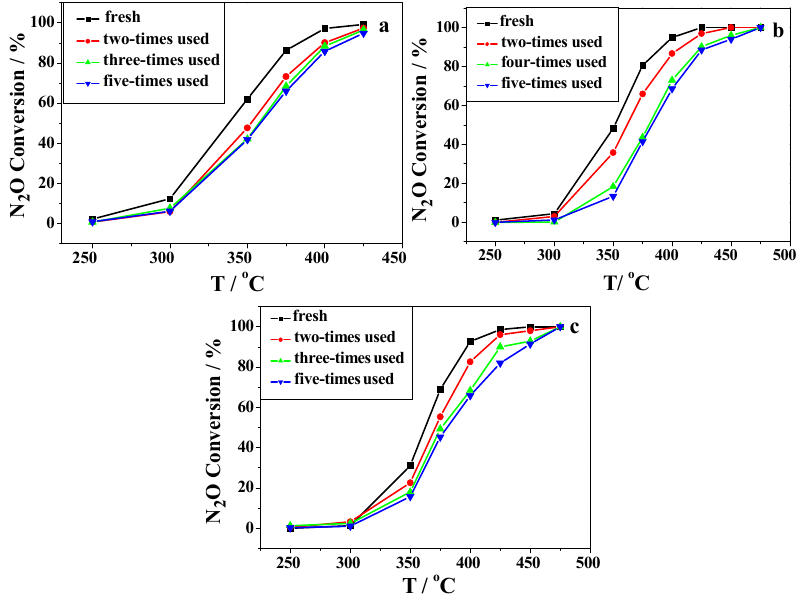
Figure 5. N 2 O conversion as a function of reaction temperature over: ( a ) Ru/Al 2 O 3 -H 2 ; ( b ) Ru/Al 2 O 3 -NaBH 4 ; ( c ) Ru/Al 2 O 3 -air catalysts (reaction condition: [N 2 O] = 5000 ppm and gas hourly space velocity (GHSV) = 11,000 h − 1